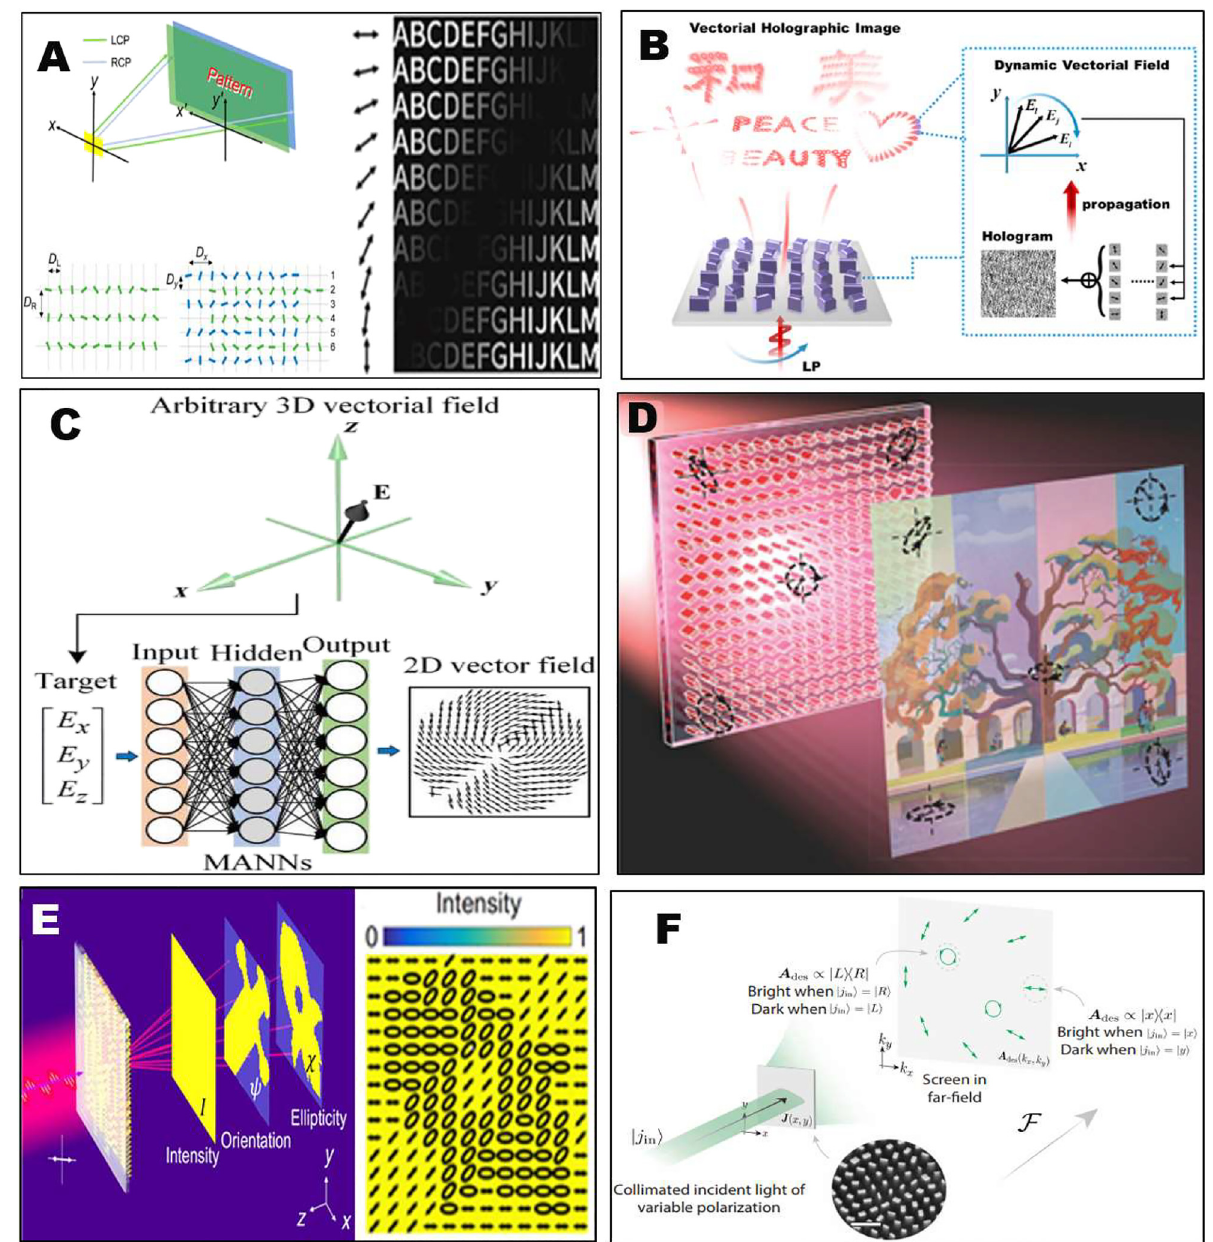
Figure 2: Vectorial holography with continuously modulated polarization distribution. (A) Left: LCP and RCP beams reflected from the metasurface form two identical holographic images but with a spatially continuous phase difference.Theunitcellofmetasurface.Right:vectorialholographicimagewithspatialcontinuouslinearpolarizationdistribution[99].(B)The dynamic display of vectorial meta-holography with 4-fold degeneracy by selecting the desired linear polarization combination continuously [100]. (C) A neural network approach used for constructing a continuous 3D vectorial fi eld in the image space from the 2D vector fi eld distribution in the hologram plane [101]. (D) A metasurface vectorial hologram projecting the full polarization parameters encoding an RGB image [65]. (E) Vectorial Fourier metasurface of arbitrary far- fi eld light distribution of intensity and continuous polarization distribution [66]. (F) The Jones matrix holograms whose far- fi elds have designer-speci fi ed waveplate or polarizer responses